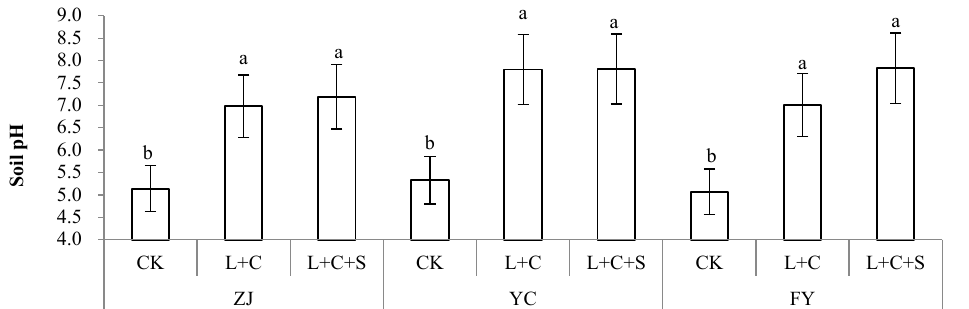
Figure 2. Paddy soil pH treated by control with no passivators (CK), 9000 kg ha − 1 of lime + biochar with a rate of 1:1 (L + C), and 9000 kg ha − 1 lime + biochar + sepiolite with a rate of 1:1 (L + C + S). Values (means ± SD, n = 3) with different letters indicate significant differences between objects in the respective sites (separately for ZJ (Zhuji), YC (Yuecheng), or FY (Fuyang)).